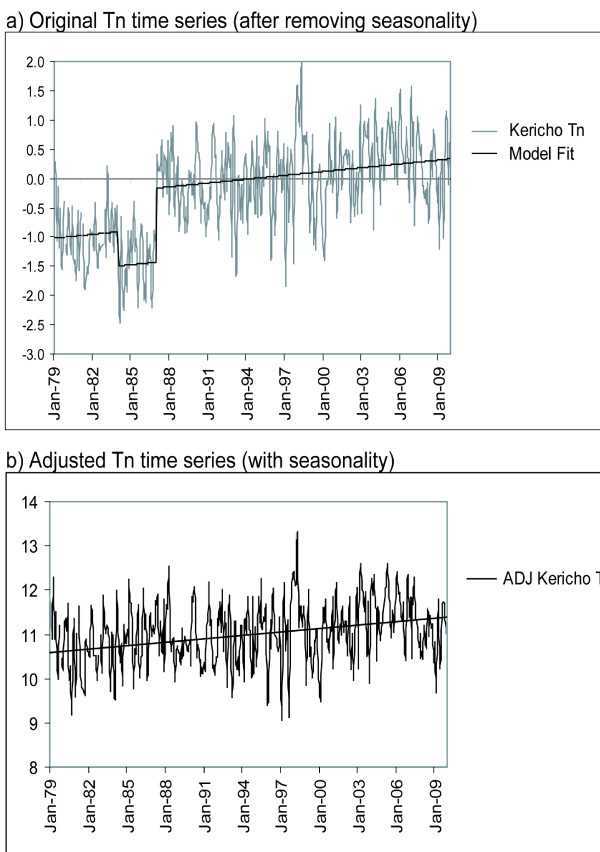
Time series of monthly values of Tn after removing seasonality (i.e., the 30-year mean values shown in Figure 1) (deg. C) for a) original data, also showing model fit, and b) adjusted data after removing two identified break-points and including seasonality. The linear trend for the full data period is shown by the solid line (see Table 1 for slope and significance).